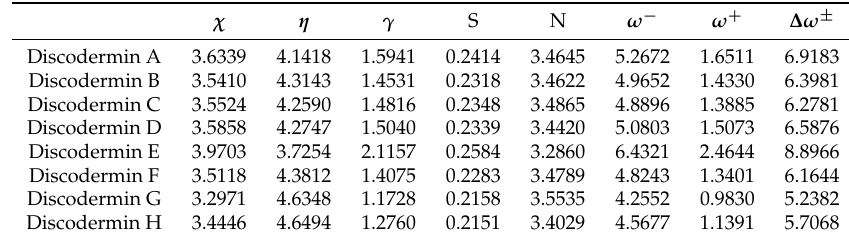
Table 4. Global reactivity descriptors for the Discodermin family of marine cyclopeptides: Electronegativity ( χ ), Hardness ( η ), Electrophilicity ( ω ) (all in eV), Softness S (in eV − 1 ), Nucleophilicity N, Electrodonating Power ( ω − ), Electroaccepting Power ( ω + ) and Net Electrophilicity ( ∆ ω ± ) (also in